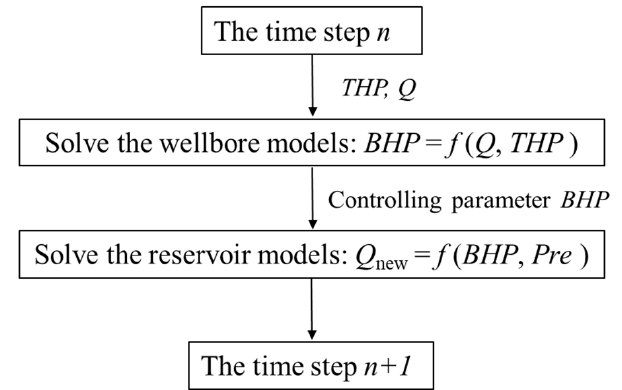
Figure 4. Schematic of the explicit coupling scheme.